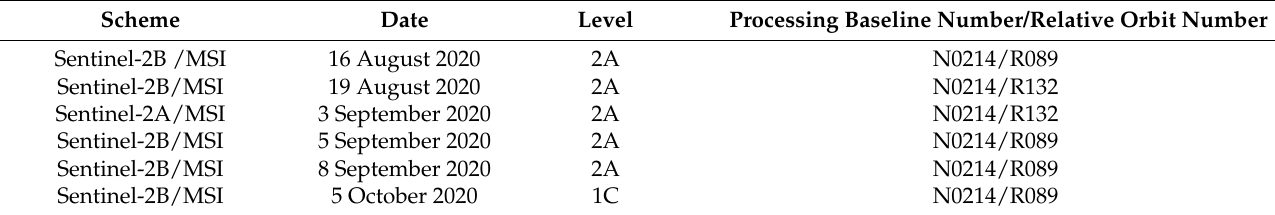
Table 1. Overview of RS data used in this